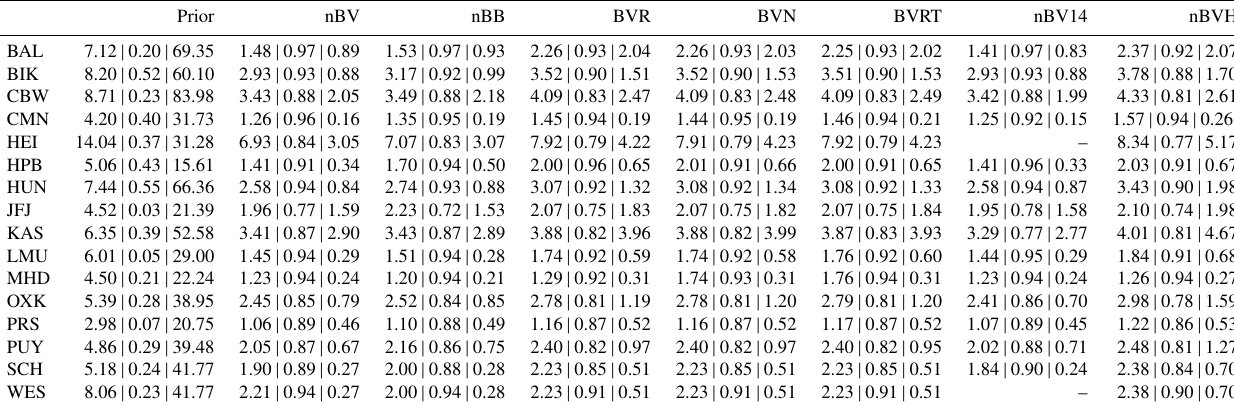
Table 3. RMSD (first column in ppm) and correlation coefficients (second column) between observations and prior–posterior CO 2 dry mole fractions for daily daytime or nighttime averaged values and for each station. The third column shows χ 2 c , the normalized dry mole fraction mismatch per degree of freedom for 7-day averaged residuals as a measure of how well the data were fitted. The format for each station is as follows: RMSD | r 2 | χ 2